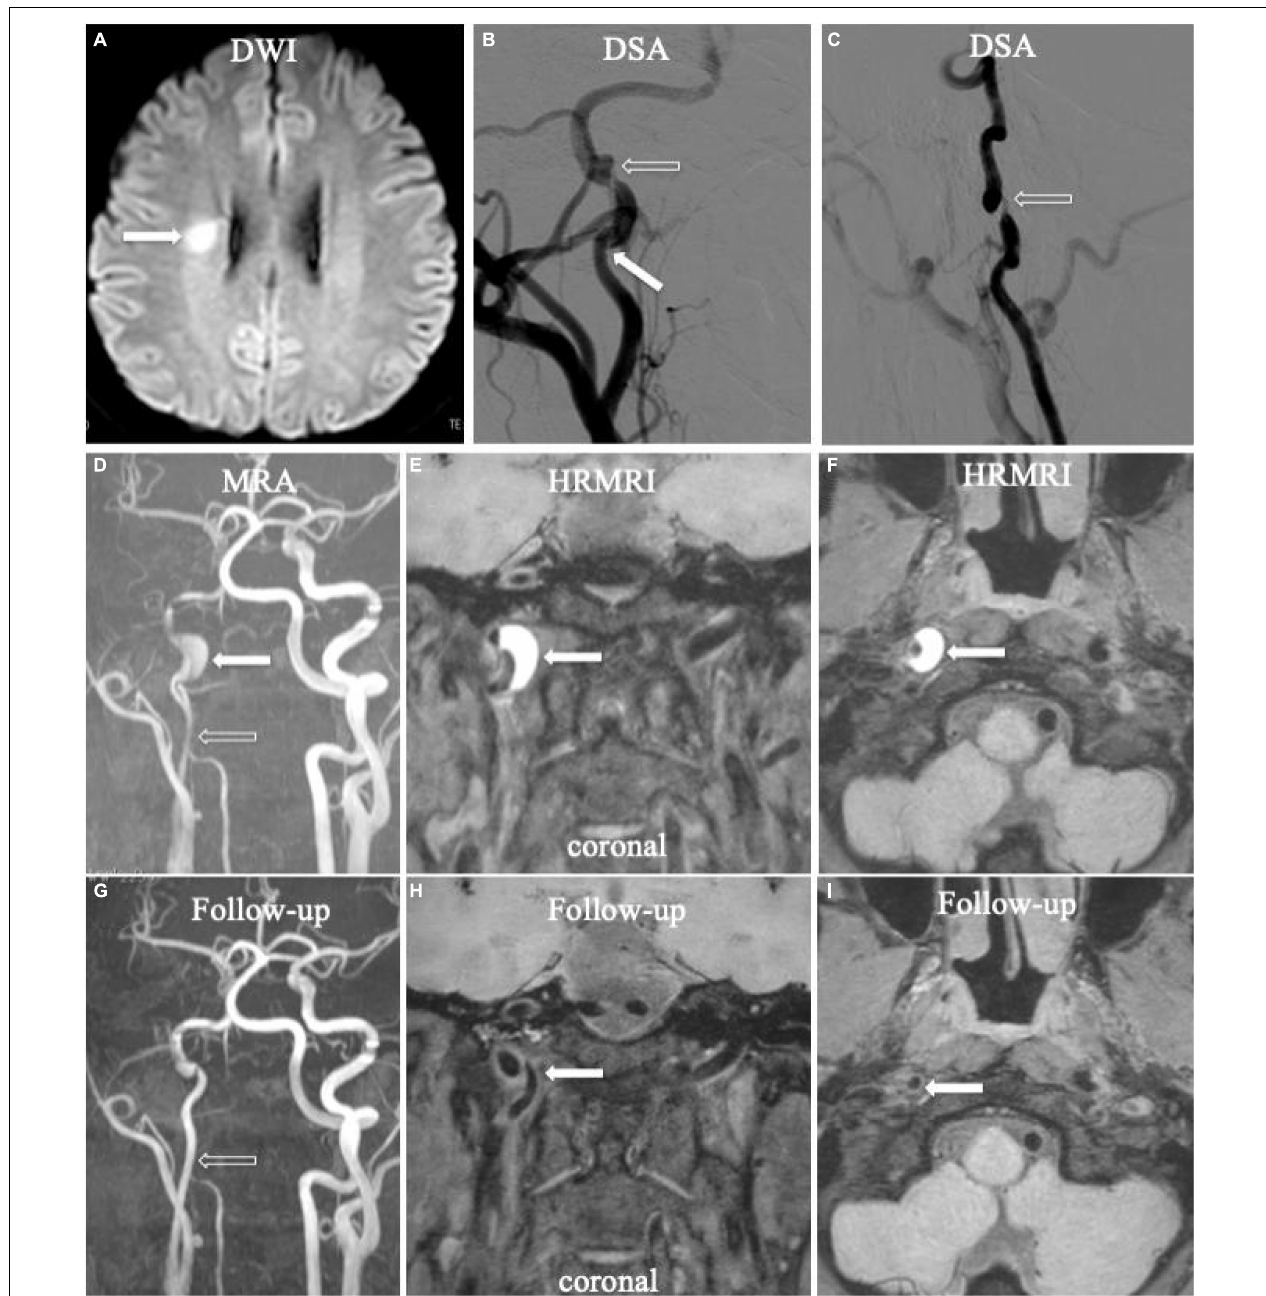
FIGURE 2 | Acute ischemic stroke ( A , arrow) in the territory of the right ICA. Digital subtraction angiography (DSA) showed aneurysmal dilation with focal stenosis ( B,C , empty arrow) and suspicious intimal flap ( B , arrow) in the right ICA. Initial MRA displayed tapered stenosis ( D , empty arrow) and a suspicious hematoma ( D , arrow). Initial HRMRI showed an intramural hematoma on the T1-weighted coronal ( E , arrow) and transverse image ( F , arrow). Follow-up MRA ( G , arrow) showed partial recanalization on the affected arterial lumen. The intramural hematoma had disappeared on follow-up T1-weighted coronal ( H , arrow) and transverse ( I , arrow)